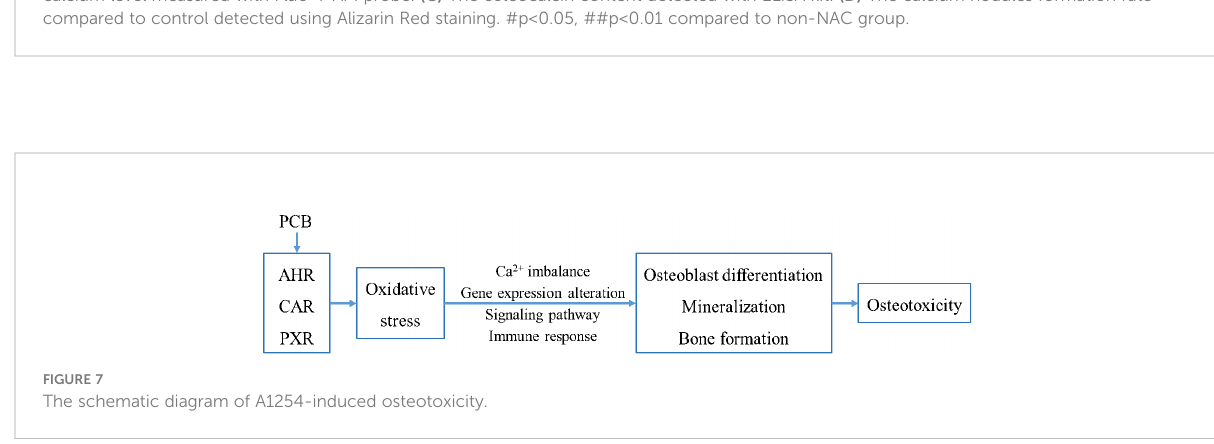
FIGURE 6 NAC partially relieved the osteotoxicity induced by A1254 exposure. MC3T3-E1 cells were treated with A1254 (10 m mol/L) alone or NAC (2 mmol/L) +A1254 (10 m mol/L) for 24 and 48h. ROS production, calcium level, osteocalcin content, and calcium nodules formation rate were measured. Data between NAC group and non-NAC group were compared with one-way ANOVA. (A) Relative ROS level after exposure. (B) The calcium level measured with Fluo 4-AM probe. (C) The osteocalcin content detected with ELISA kit. (D) The calcium nodules formation rate